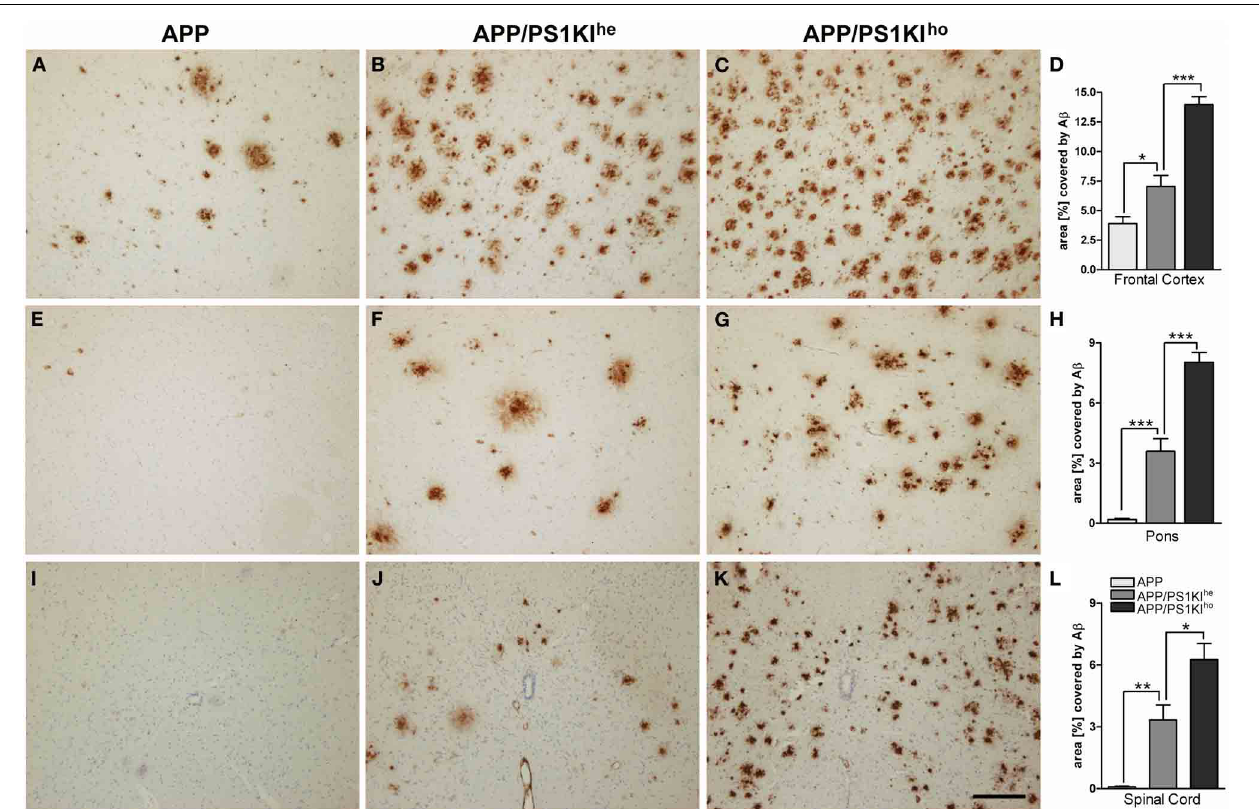
of A β was found to rise significantly in all three regions investigated and further approximately doubled with the introduction of an additional PS1KI gene (APP/PS1KI ho mice), reaching percentile A β covered areas of 14, 8, and 6.5% in the frontal cortex, pons, and spinal cord, respectively. Data was analyzed from 6 mice of each genotype and analyzed using One-Way ANOVA followed by t -tests. All error bars represent mean ± s.e.m. ∗∗∗ P < 0 . 001; ∗∗ P < 0 . 01; ∗ P < 0 . 05. Scale bar: 200 μ